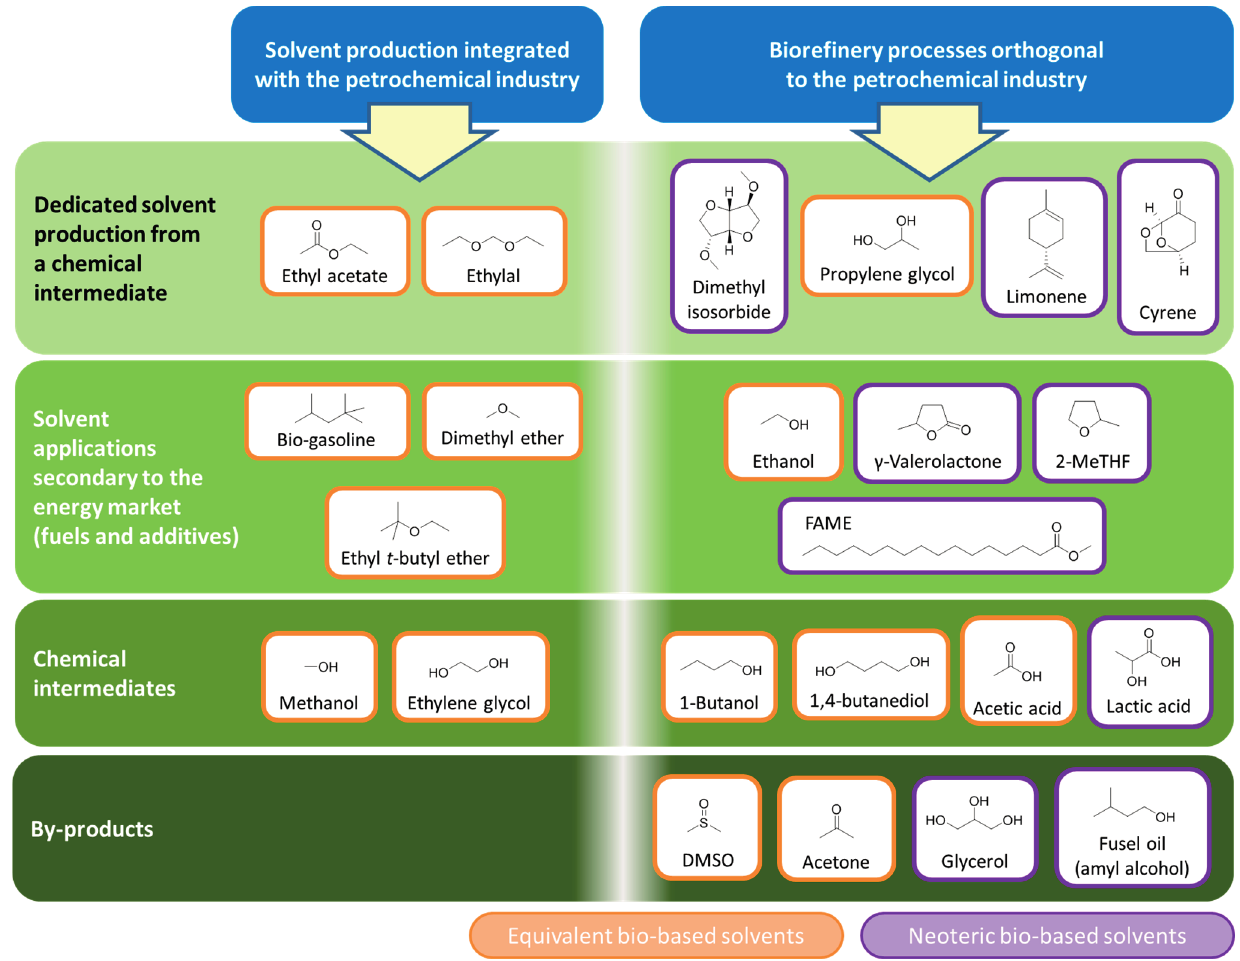
Figure 6. The relationship between different bio-based solvents according to their origin and their place in the chemical industry